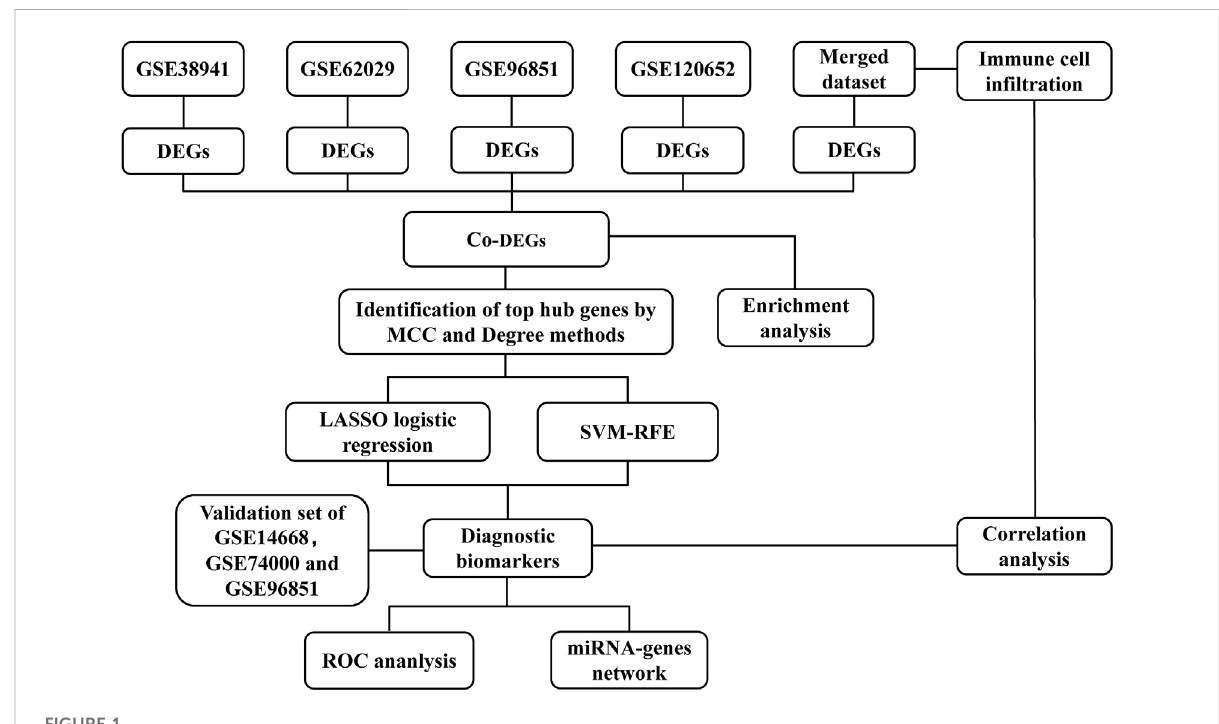
FIGURE 1 Flowchart of data collection and analysis.